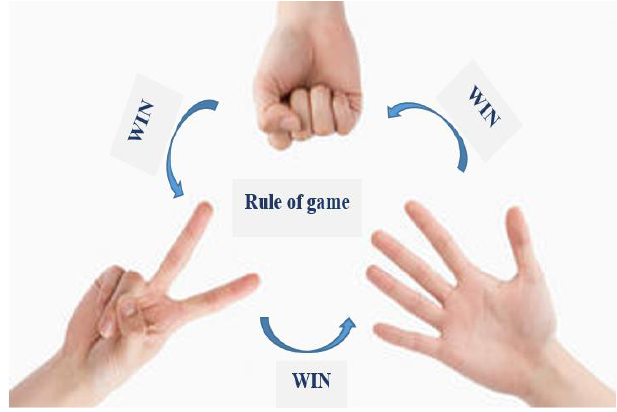
Fig. 1. The general rule of Rock paper scissors